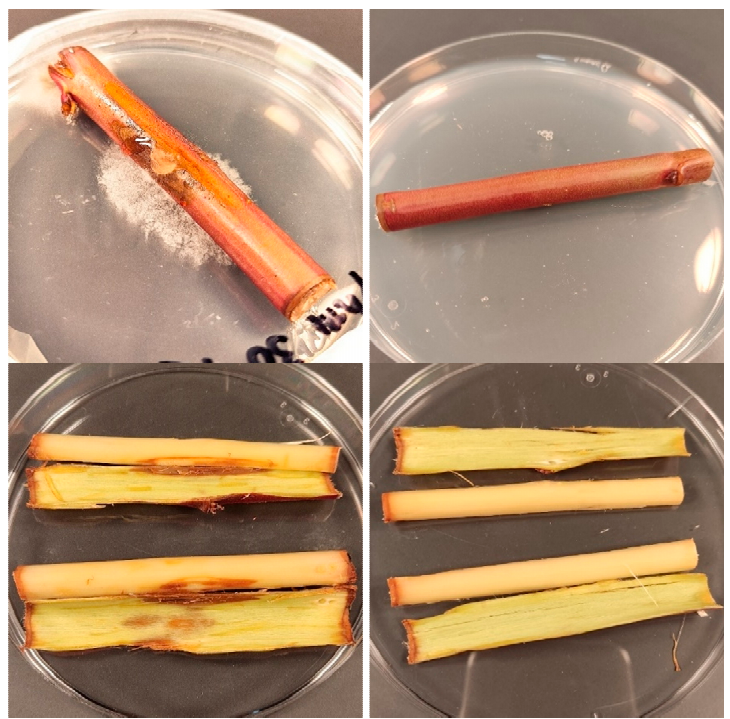
Figure 4. ‘Garnem’ stem segments artificially inoculated with P. megasperma after 4 days of incubation: ( left ) untreated samples ( top : outer bark; bottom : cambium); ( right ) samples ( top : outer bark; bottom: cambium) treated with S. nigra flower aqueous ammonia extract at 1875 μ g·mL − 1 (MIC×5).